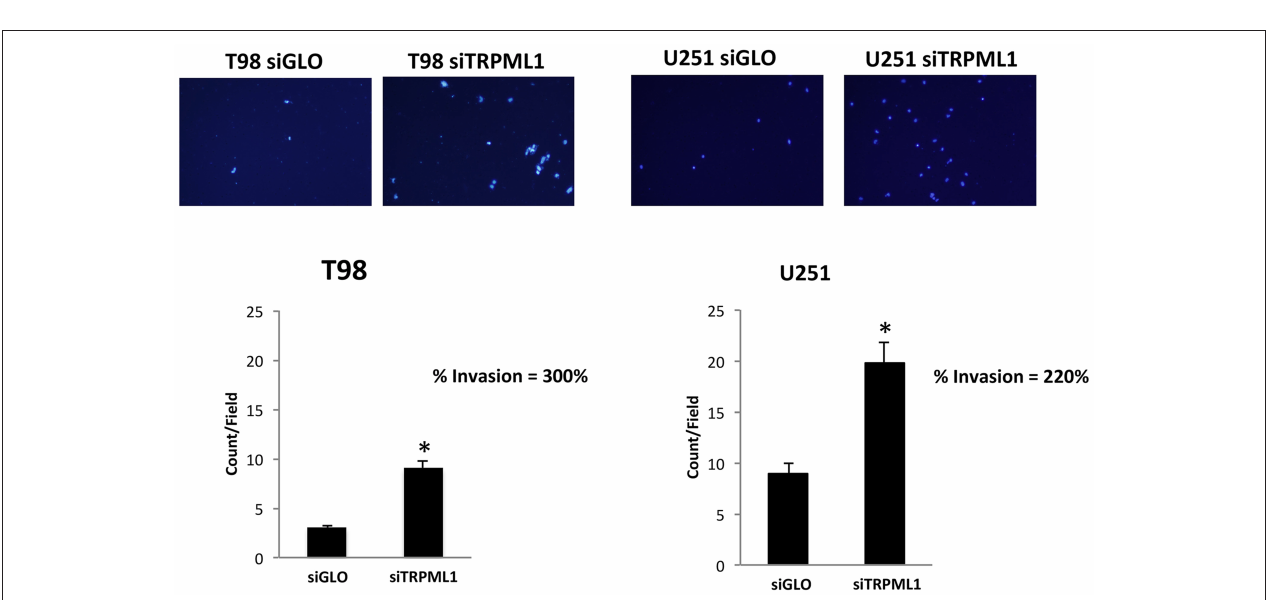
FIGURE 7 | Transient receptor potential mucolipin 1 (TRPML1) silencing increases invasion in glioma cell lines. Representative images showing DAPI fluorescence after 24h culture in Transwell chambers ( × 10 magnification). The invading cells were counted in 10 randomly chosen microscopic fields per transwell. Each sample was run in triplicate, and three independent experiments were performed. Bars represent the quantification of invaded cells in each field. Error bars represent ± SE. * p <